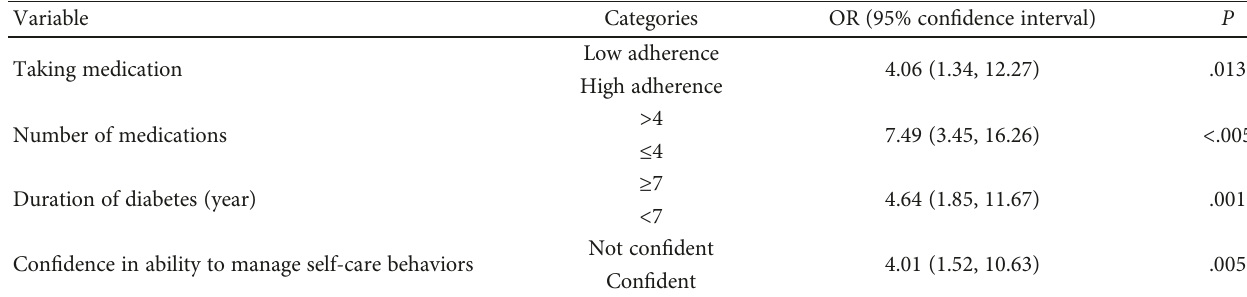
Table 5: Regression model for factors associated with